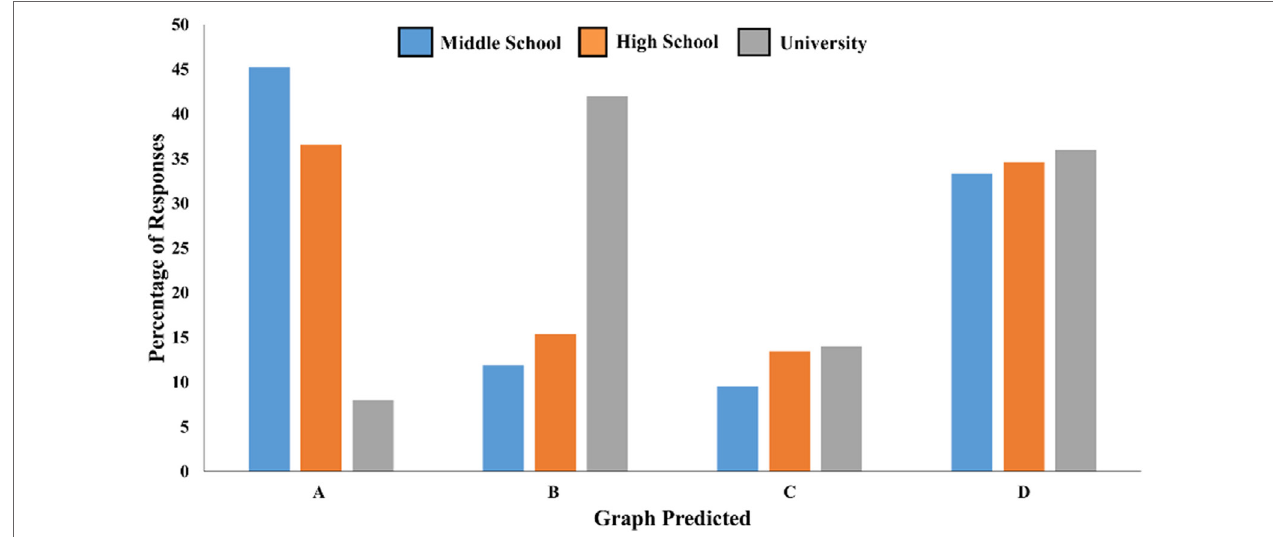
FigUre 13 | Frequency of responses by graph type for middle school ( n = 42), high school ( n = 52), and university instructors ( n =